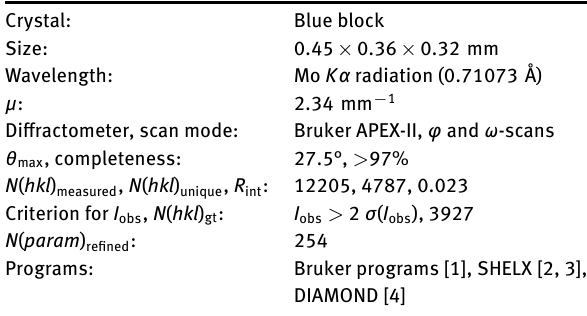
Table 2: Fractional atomic coordinates and isotropic or